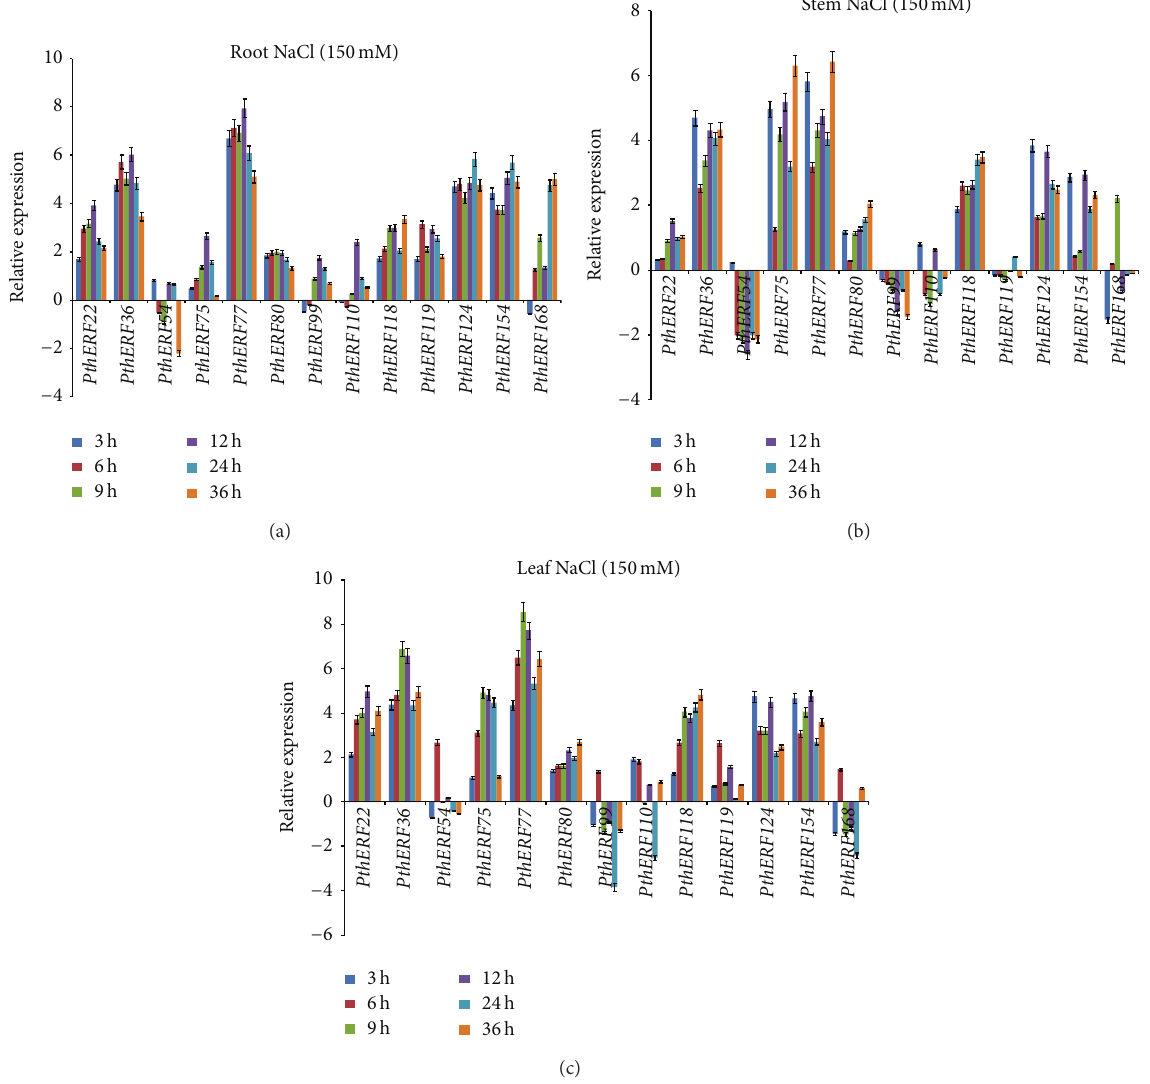
Figure 3: Spatial-temporal expression of 13 PthERFs under salt stress in different tissues. Relative expression level was log 2 transformed: > 0: upregulation; =0: no change in regulation; < 0: downregulation; (a) in roots; (b) in stems; (c) in leaves.